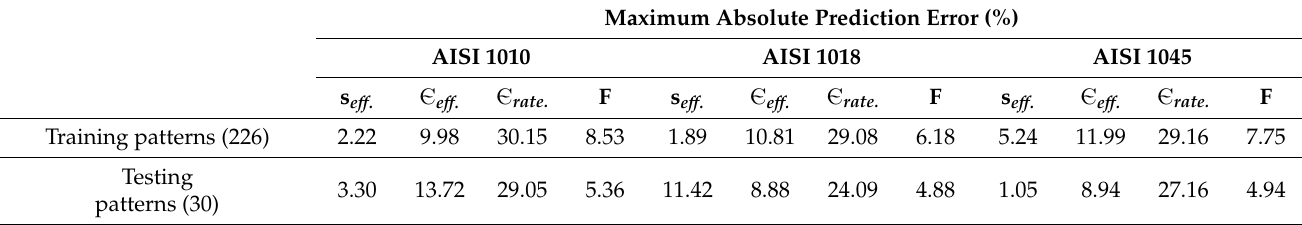
Table 6. ANN training performance.